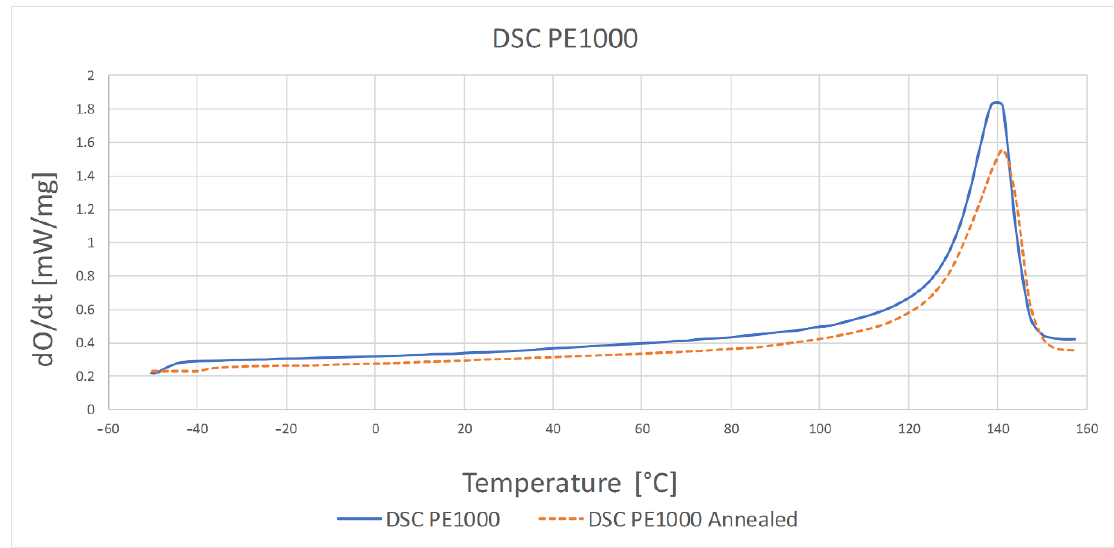
Figure 4. DSC thermogram for PE1000 before and after heat treatment.